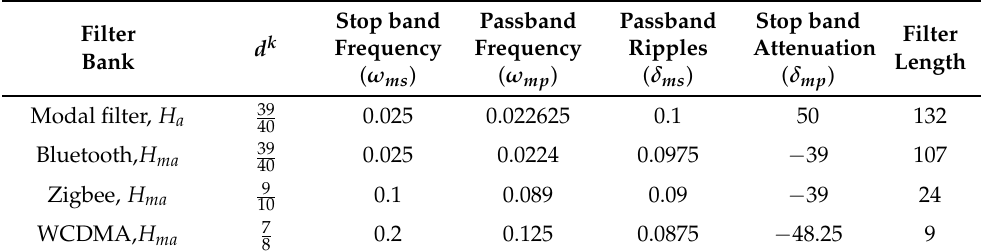
Table 4. The frequency characteristics of masking filters implemented using the HFarrow filter bank.